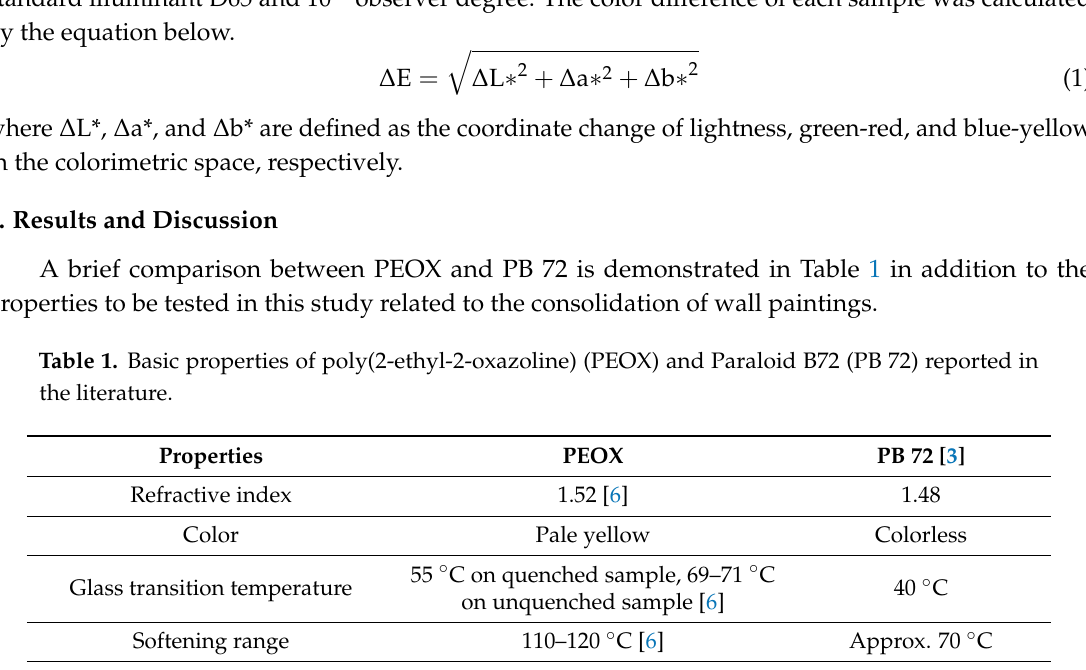
Table 1. Basic properties of poly(2-ethyl-2-oxazoline) (PEOX) and Paraloid B72 (PB 72) reported in the literature.